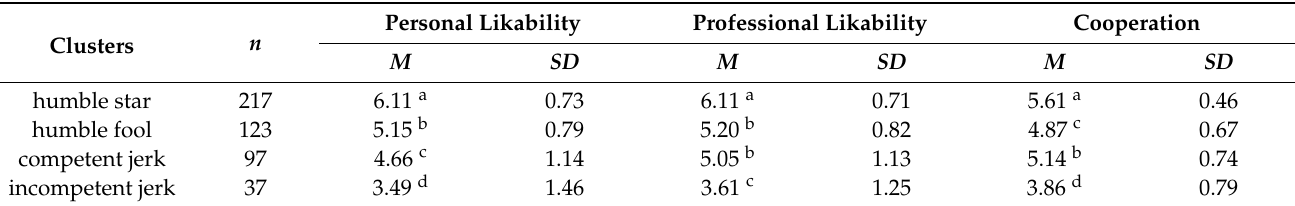
Table 3. Means and Standard Deviations of the Study Variables in Each Cluster.